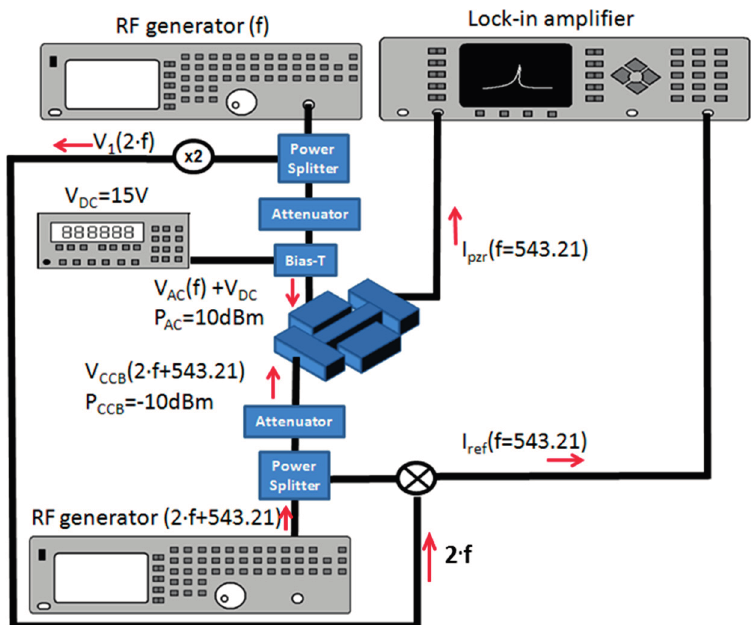
Figure 3. Piezoresistive sensing set-up with an electrostatic excitation. f will be around